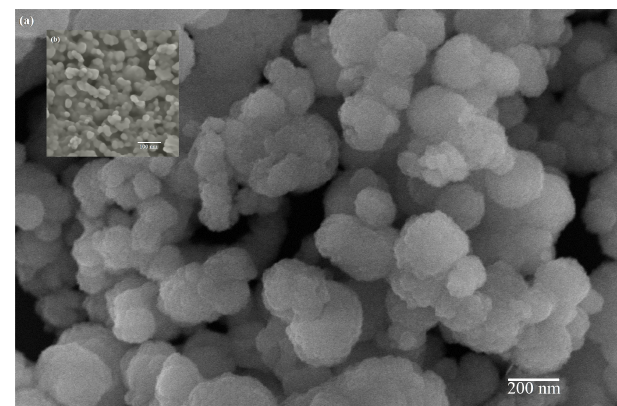
Figure 2. SEM images of synthesized ZnS Nps with different mag- nifications: (a) magnification was 40000 × and the scale bar was 200nm; (b) magnification was 4000 × and the scale bar was